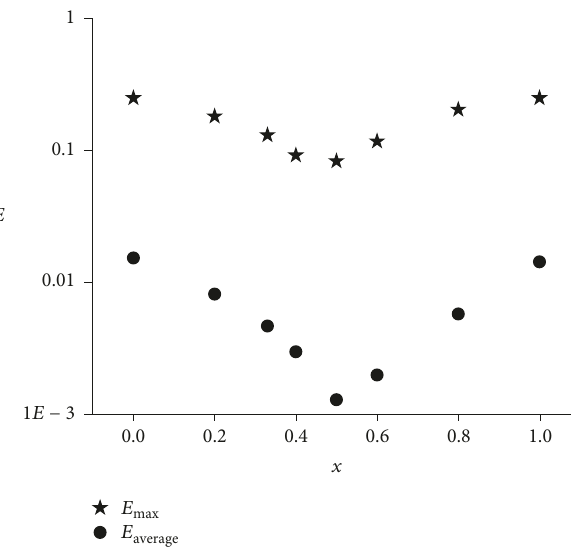
Figure 3: Bottom: average repulsive energy per wire in the bar code as function of the presence of up magnetization; top: maximum repulsive energy for any wire in the configuration with the corre- sponding proportion of up magnetization (wire located at the white star position in the previous